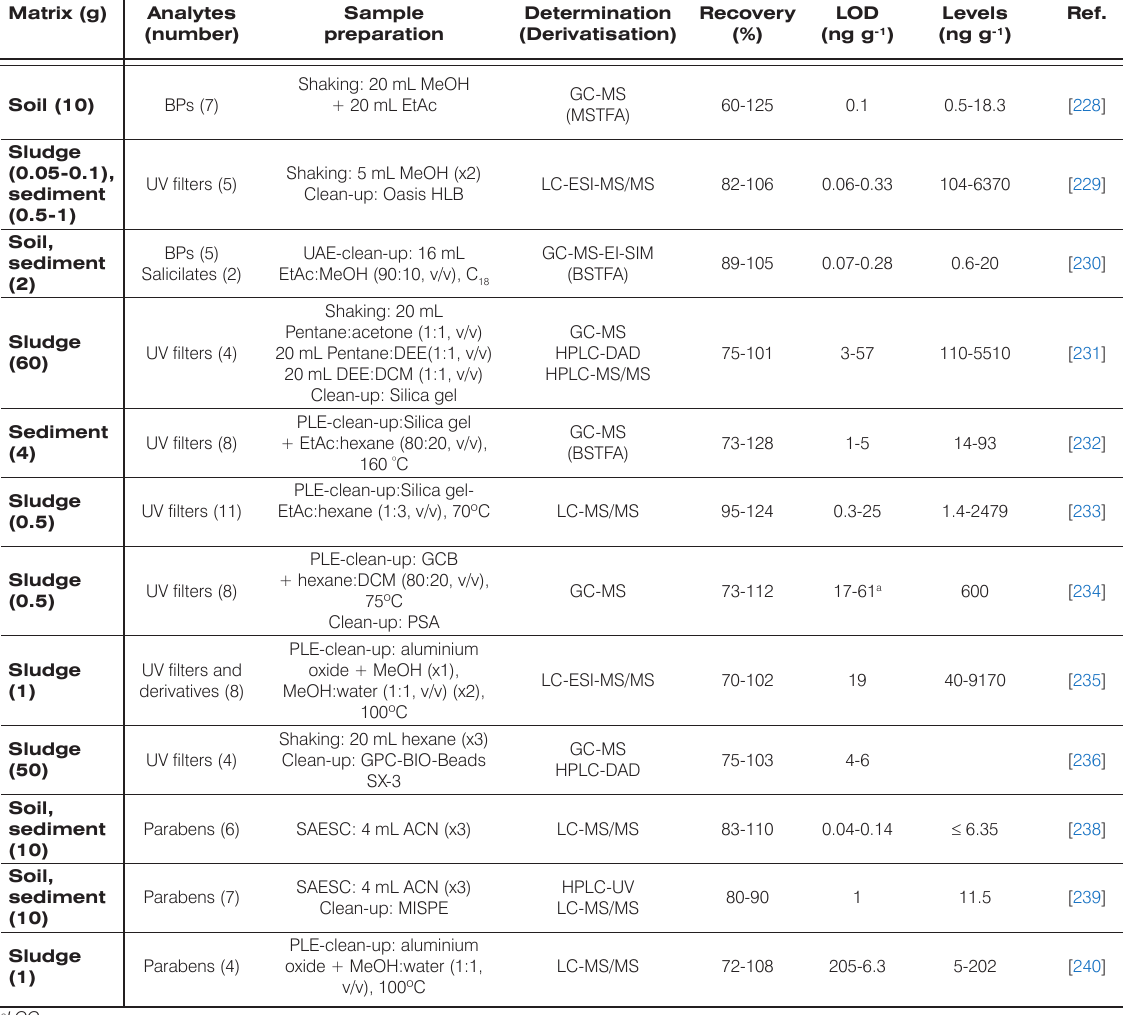
Table 10. Analysis of UV filters and parabens in environmental solid